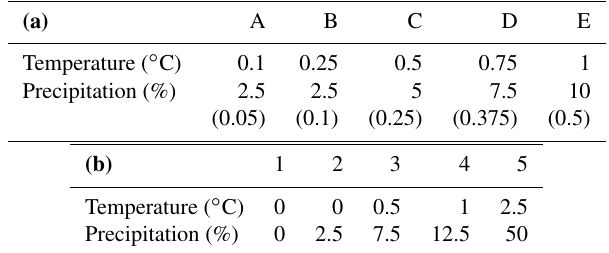
Table 1. Station classifications and related measurement uncer- tainty – standard deviation, computed as half of the 95% confidence interval – for daily temperature and daily precipitation. (a) Main- tained performance (Leroy, 2010). The standard deviation for pre- cipitation is selected as the maximum between the percentage value and the minimum value indicated in brackets (in mm). (b) Repre- sentativeness of the site (Leroy and Lèches,